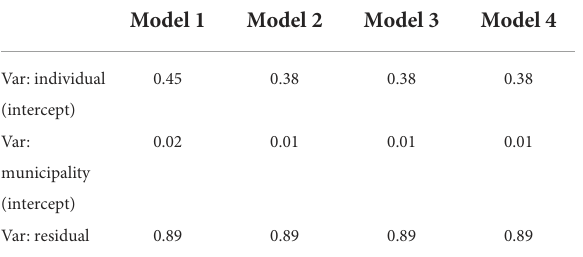
TABLE 7 Multilevel linear regression models for